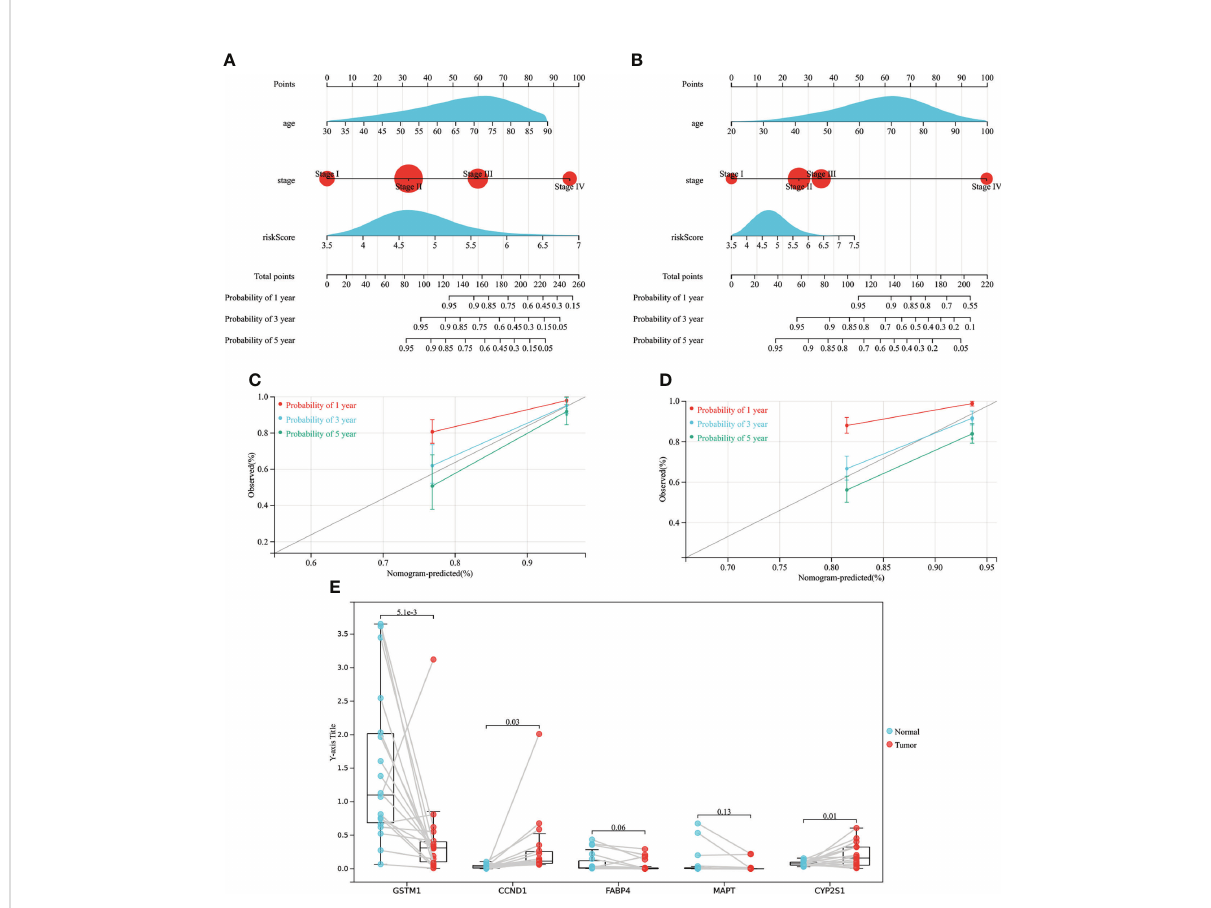
FIGURE 9 The establishment of the nomogram and gene expression validation. (A) Establish a Nomogram based on TCGA. (B) Establish a Nomogram based on GEO. (C) 1-, 3-, 5-year calibration curves of TCGA. (D) 1-, 3-, 5-year calibration curves of GEO. (E) Gene expression